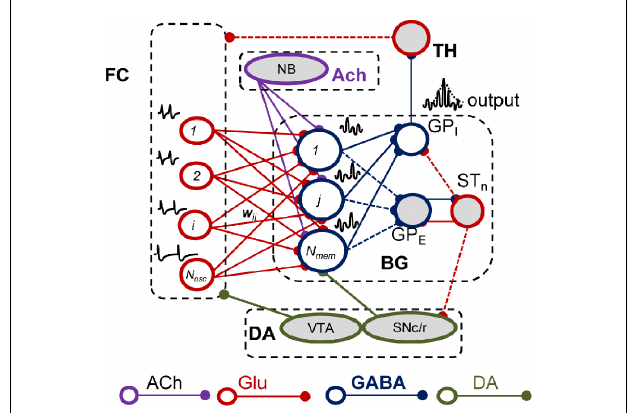
FIGURE 4 |The striatal beat frequency model. Schematic representation of the neurobiological structures involved in interval timing in the SBF model. Dashed lines signify couplings that are not implemented in our SBF version. Frontal oscillators are implemented as biophysically realistic ML neurons. ACh, acetylcholine; FC, frontal cortex; BG, basal ganglia; DA, dopamine; Glu, glutamate; GP E , globus pallidus external; GP I , globus pallidus internal; STn, subthalamic nucleus; SNc/r, substantia nigra pars compacta/reticulata;TH, thalamus;VTA, ventral tegmental